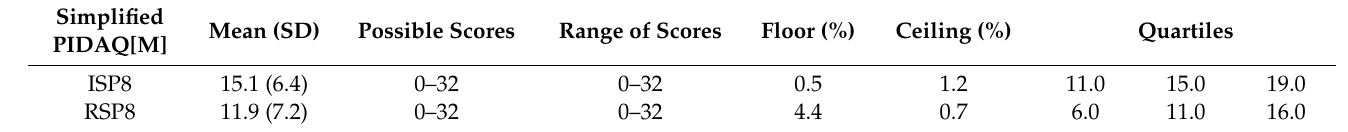
Table 2. Descriptive statistics for the simplified PIDAQ[M] (n =